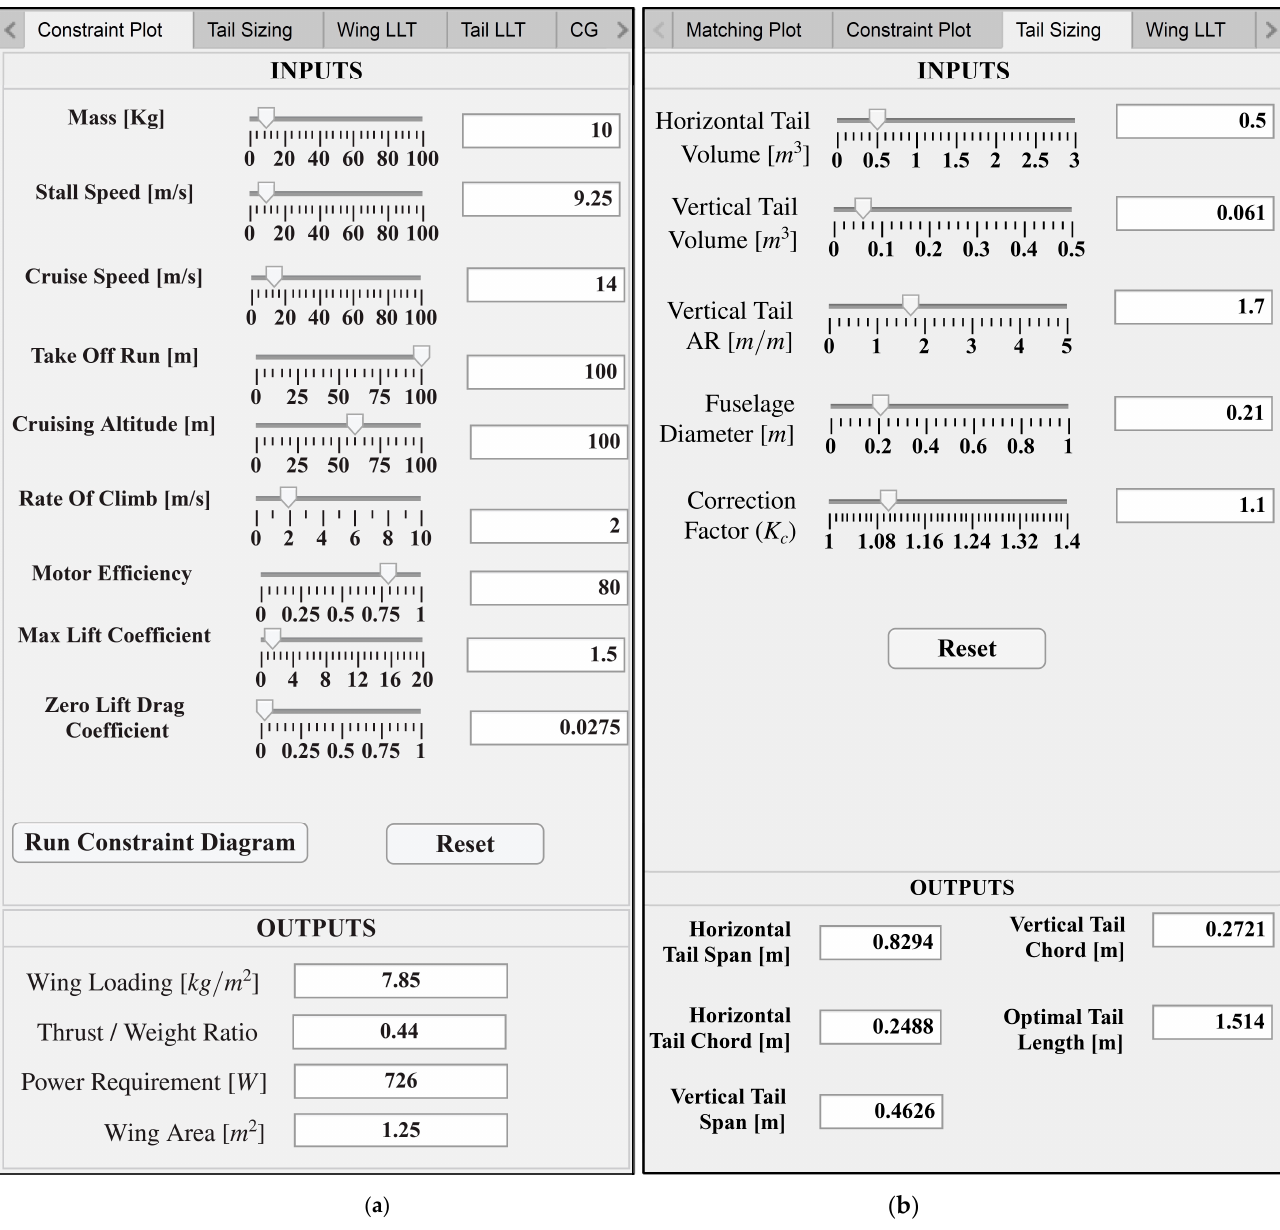
Figure 3. ( a ) Constraint Diagram input parameters, and ( b ) Tail Sizing input parameters